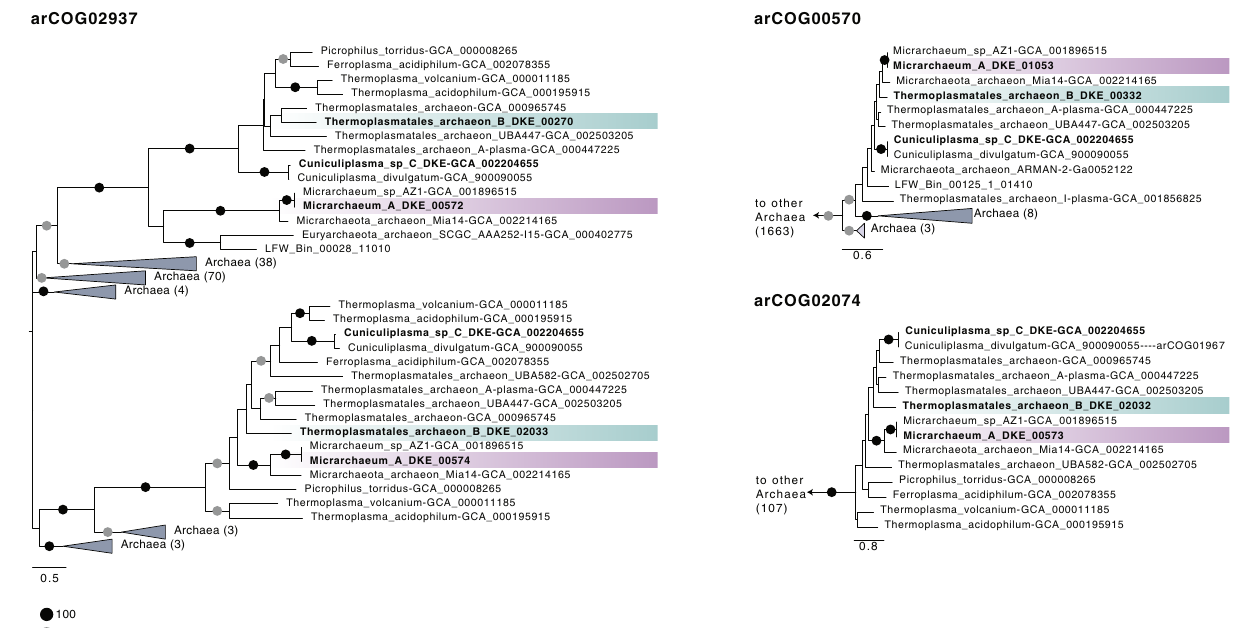
Fig. 5 Schematic trees of three protein families with indications for gene transfers between acidophilic Micrarchaeota and Thermoplasmatales . Ca . Schef fl eriplasma hospitalis and Ca . Micrarchaeum harzensis genes are highlighted in light blue and violet, respectively. The Maximum likelihood phylogenetic trees shown here included our archaeal backbone dataset (Supplementary Data 7) and were inferred for arCOG02937 (149 sequences with 304 amino acids), arCOG00570 (1877 sequences with 132 amino acids) and COG2074 (arCOG01968 and arCOG01967, 121 sequences with 171 amino acids) with the LG + C10 + F + R model with an ultrafast bootstrap approximation run with 1000 replicates. Please note, that the inclusions of bacterial and eukaryotic homologues did not change the interpretation of our fi ndings. Note that arCOG02937 and arCOG02074 represent the key enzymes of the Type-III mevalonate pathway characteristic of Thermoplasmatales . Only bootstrap support values above 90 are shown as indicated in the